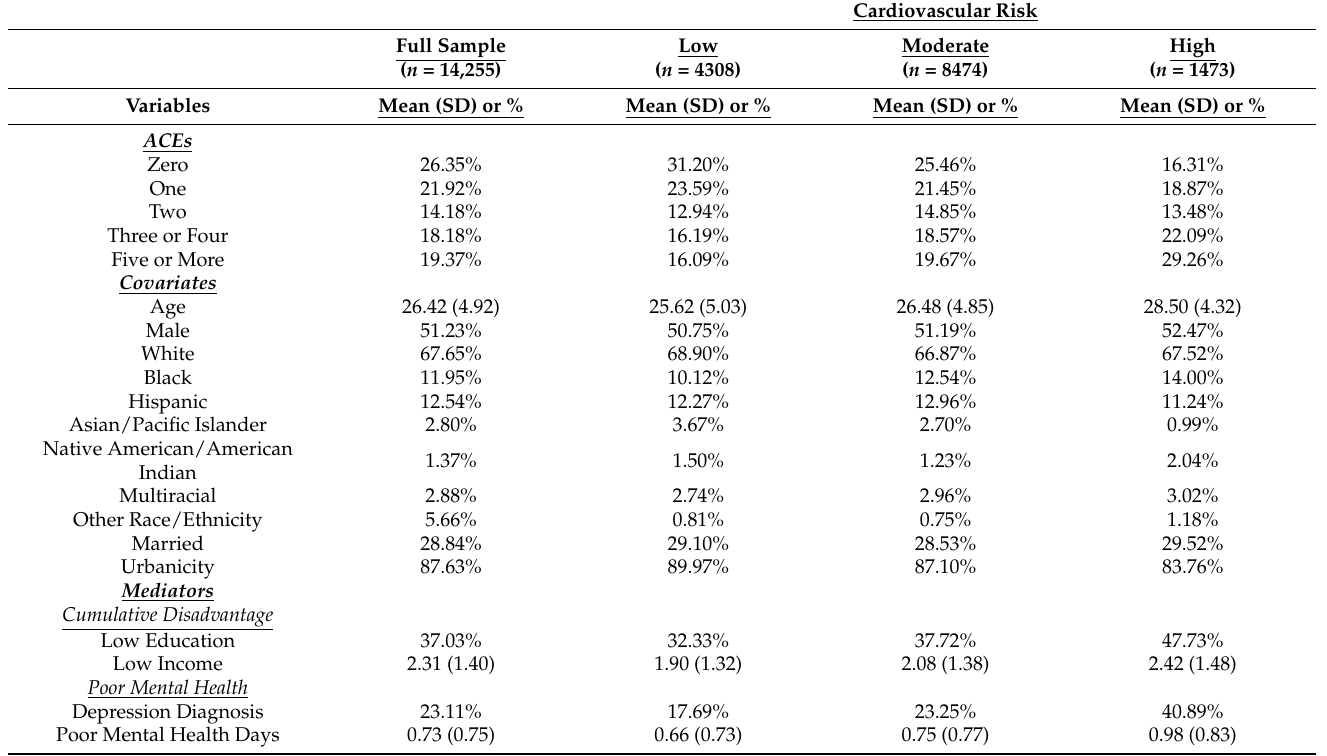
Table 1. Descriptive statistics ( n =